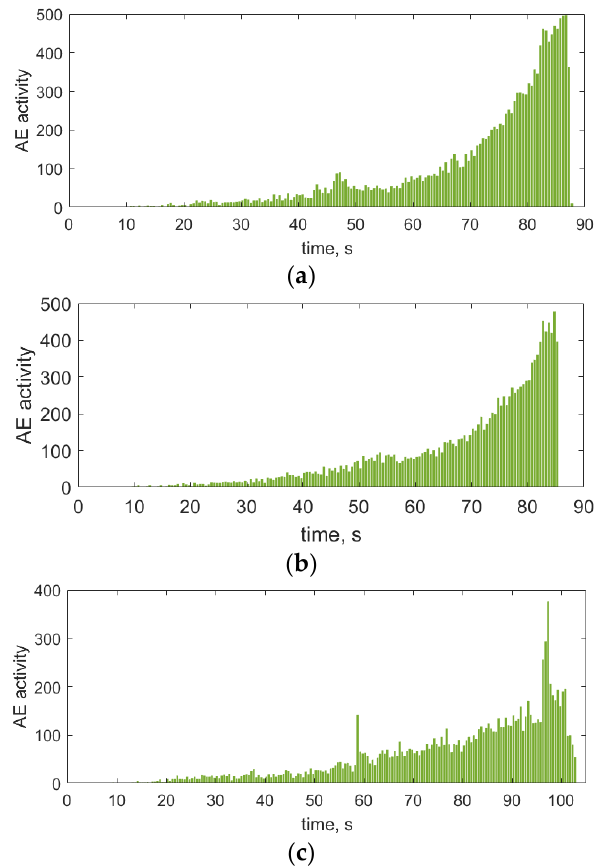
Figure 2. Acoustic emission activity under quasi-static uniaxial tension of woven laminate samples cut along the warp ( a ) and weft ( b ) directions and unidirectional CFRP samples ( c ); the ordinate shows the number of pulses recorded every half second.